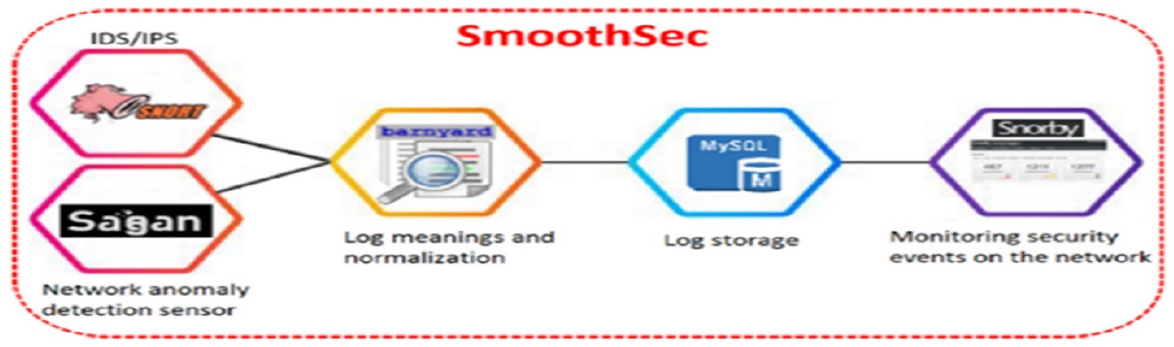
Fig. 1: Complete layout of Smooth-sec software